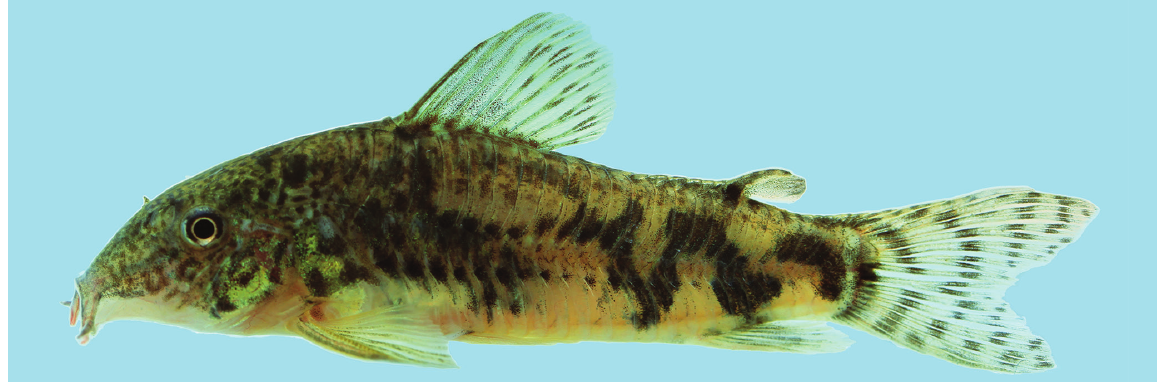
Fig. 6. Scleromystax reisi , paratype, female, UFRGS 19189, 46.1 mm SL, Estação Experimental Agronômica, Universidade Federal do Rio Grande do Sul, Eldorado do Sul, RS, Brazil.